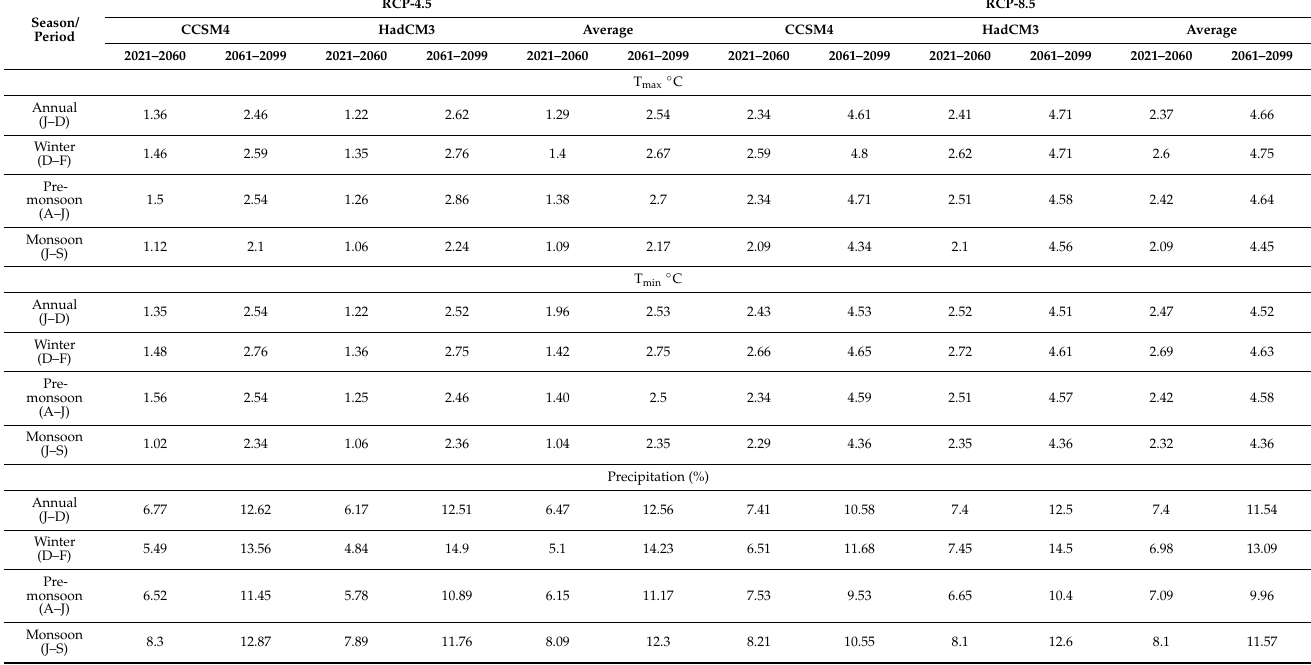
Table 9. Projected changes in mean T max ( ◦ C), T min ( ◦ C) and total precipitation (%) on annual